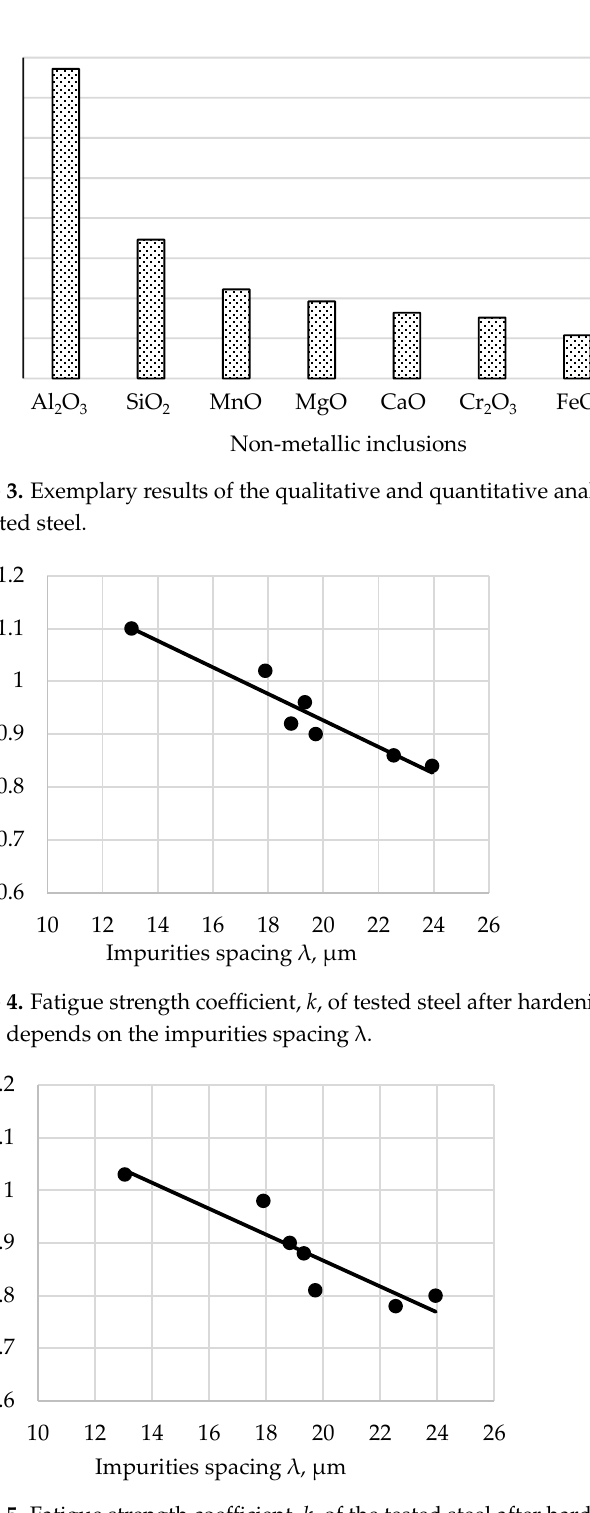
Figure 5. Fatigue strength coefficient, k , of the tested steel after hardening from 880 ◦ C and tempering